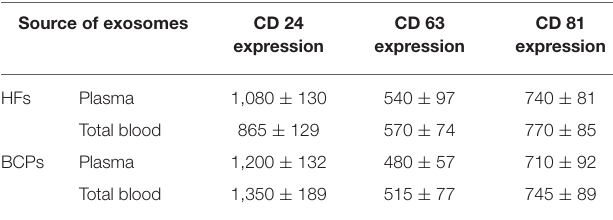
TABLE 2 | Expression of CD 24, CD 63, and CD 81 on the surface of CD9-positive exosomes from plasma and total blood of HFs and BCPs * . Source of exosomes